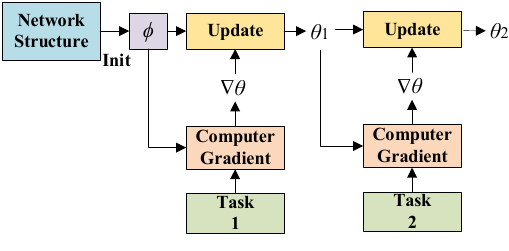
Figure 1. MAML update process.